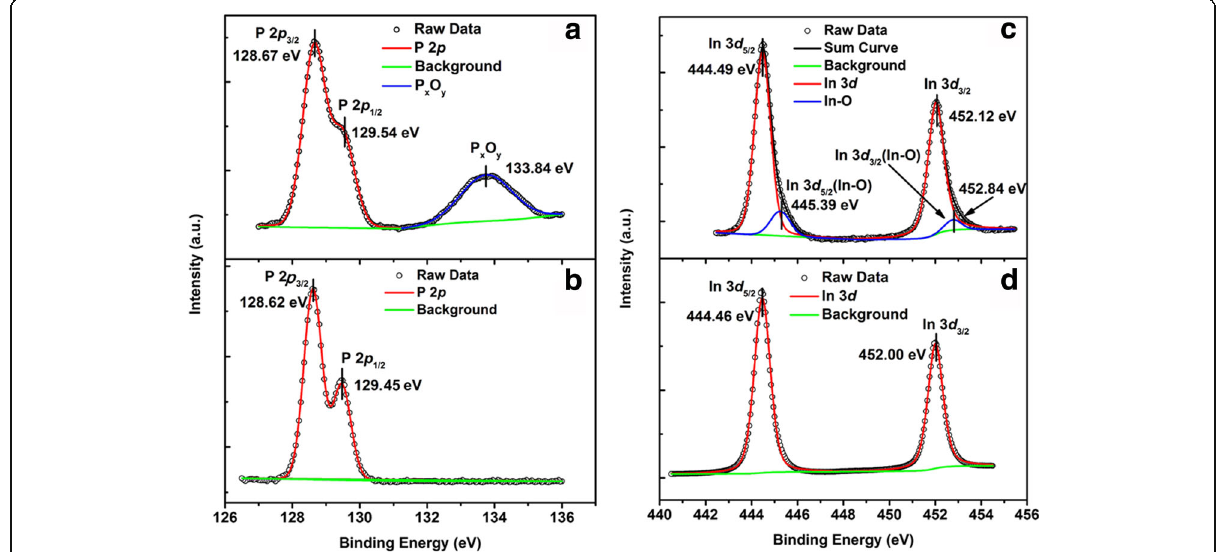
Fig. 2 P 2 p spectra for a HfO 2 (4 nm)/InP heterojunction and b bulk InP; In 3 d spectra for c HfO 2 (4 nm)/InP heterojunction and d bulk